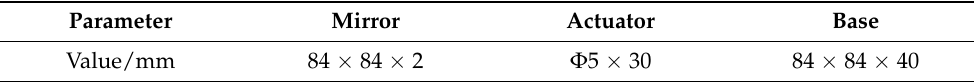
Table 3. Material parameters of the DM.